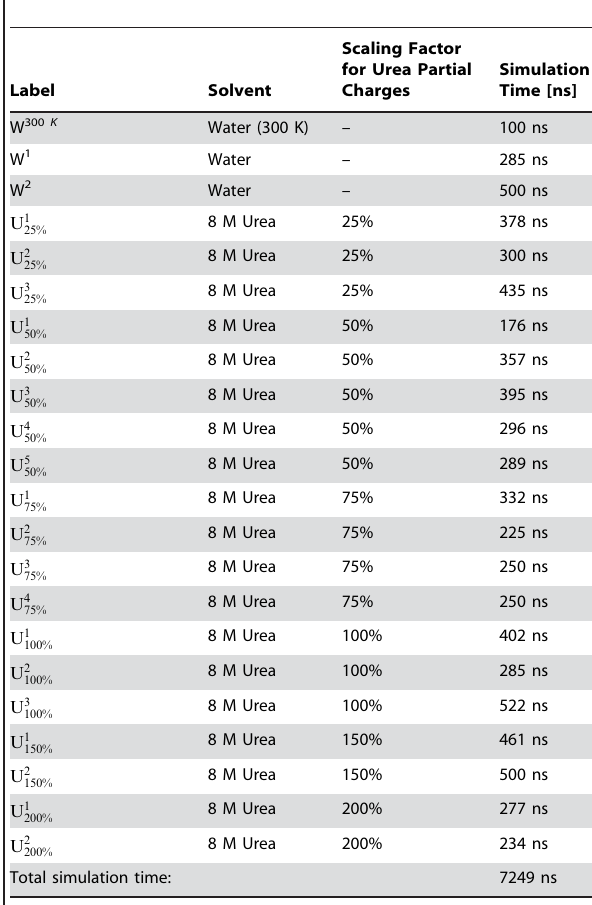
Table 1. Solvent, partial charge scaling, and length of all 22 simulation runs discussed in the